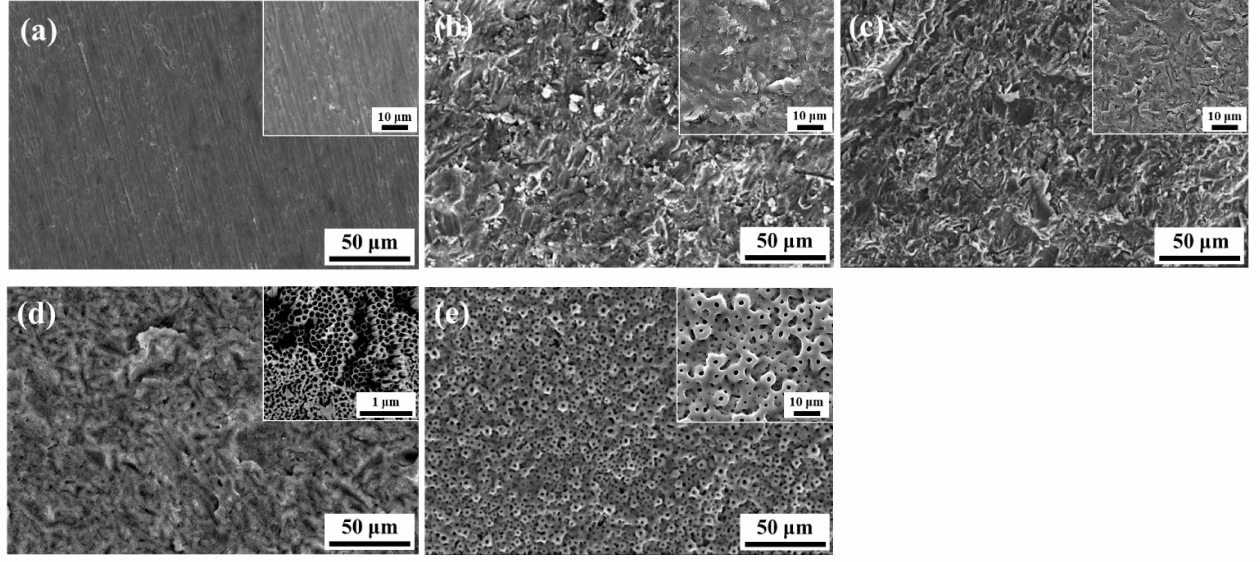
Figure 1. Surface morphology of surface-modified Ti through various treatments: ( a ) Ti, ( b ) hydroxyapatite blasting (HA), ( c ) sandblasted and acid-etched (SLA), ( d ) SLA/anodic oxidation (AO), and ( e ) SLA/micro arc oxidation (MAO).